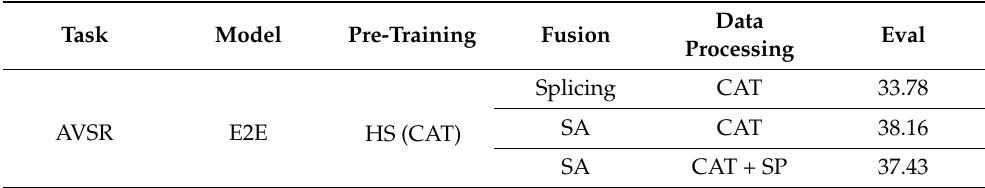
Table 6. The results (CER %) of audio–visual fusion (self-attention in the encoder part) methods. HS means the hybrid system. CAT and SP mean splicing the continuous segments and speed perturbation, respectively. ‘Splicing’ means directly splicing the two modal features in audio–visual fusion. SA means